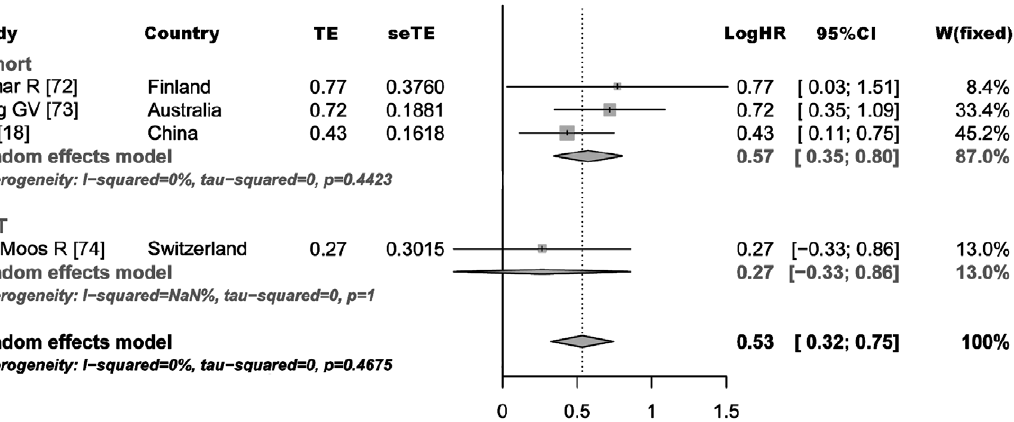
Figure 3. Random effect model of Log hazard ratio (LogHR) with 95% confidence interval for studies comparing the effect of BRAF- V600E mutation on overall survival in melanoma patients. A LogHR , 0 implies a survival benefit for patients with BRAF mutation. The square size indicates the power of each study in meta-analysis based on the number of patients in that study. The center of diamond shape at the lowest part indicates the combined LogHR for meta-analysis and its extremities the 95% confidence interval.